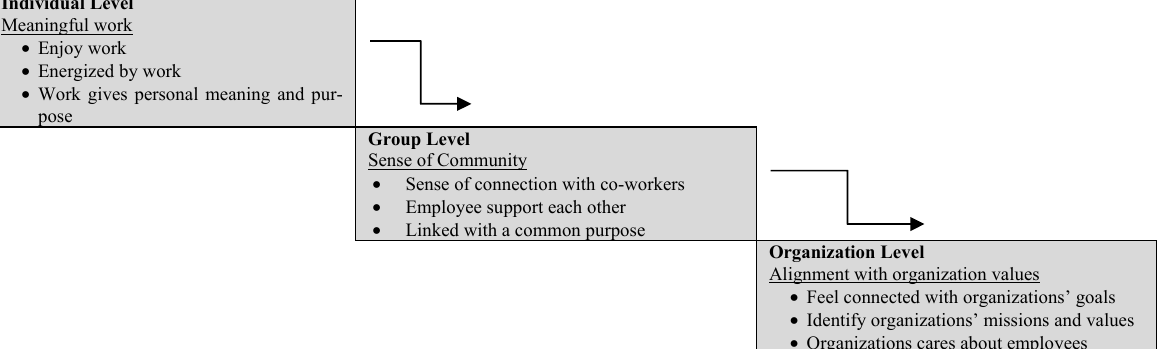
Fig. 1. Extracting spirituality in the workplace: interactions at the individual, group, and organizational levels (Milliman et al.,